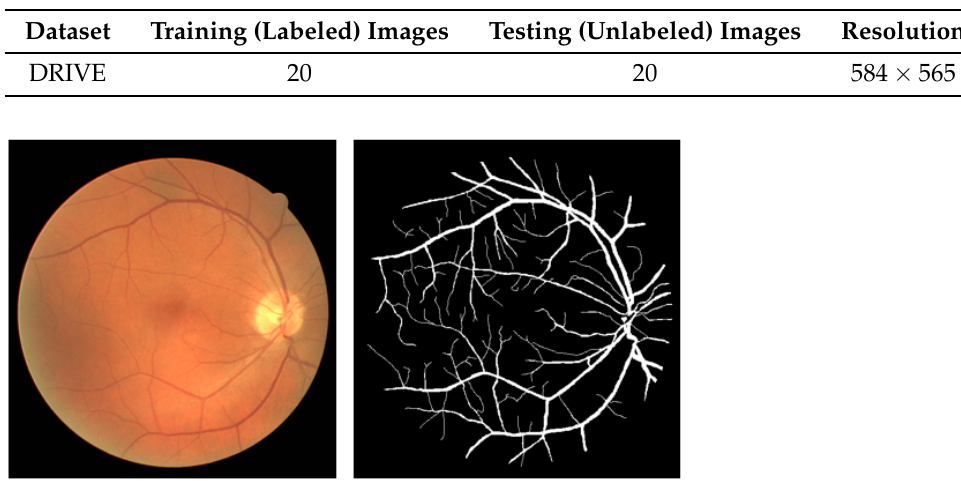
Table 1. Table summary of the DRIVE dataset main features.